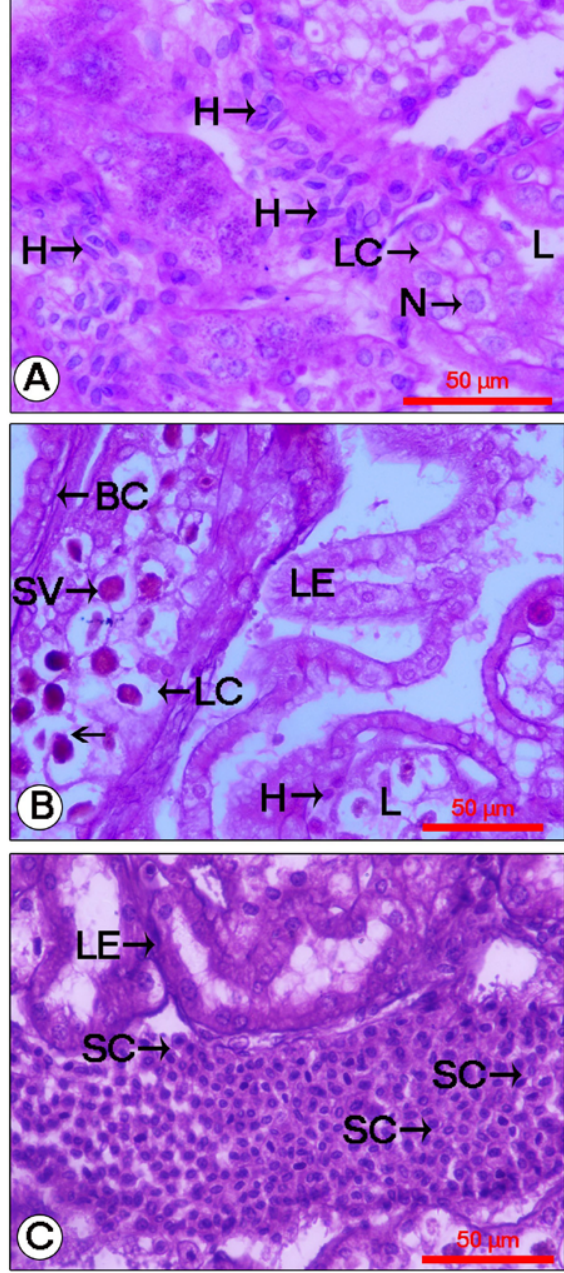
Figure 7. Light micrograph of Y-organ of crabs treated with 20E during C4 stage in Travancoriana schirnerae. ( A ) Abundance of hemocytes in the inter-lobular hemal spaces. ( B ) Secretory vesicles seen attached to the cell membrane showing the holocrine mode of release of secretion. ( C ) Proliferated smaller cells seen in large patches. BC: Blood capillary; H: Hemocyte; L: Lobule; LC: Larger cell; LE: Lobular epithelium; N: Nucleus; SC: Smaller cell; SV: Secretory vesicle; Arrow indicates the secretory vesicle attached to the lobular